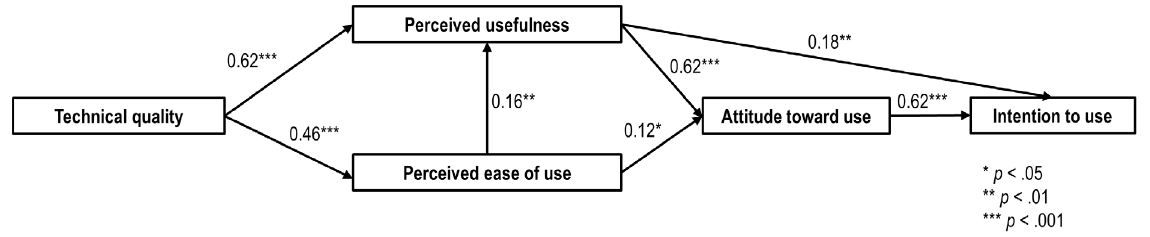
Figure 2. Results of the path analysis (Final